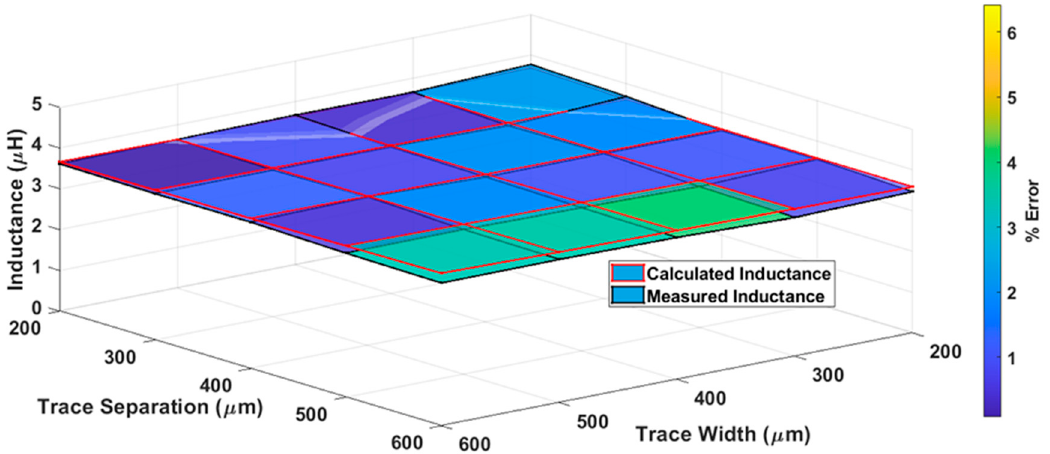
The measured inductances (black lines) and proposed model inductances (red lines) with color bar graphs for various trace separations and trace width are represented graph- ically in Figure 8. It is evident from Figure 8 that the proposed model inductance and measured inductance values are approximately the same, with a percentage difference of less than 5% between the values. This difference is primarily associated with fabrication inaccuracies and measurement errors.